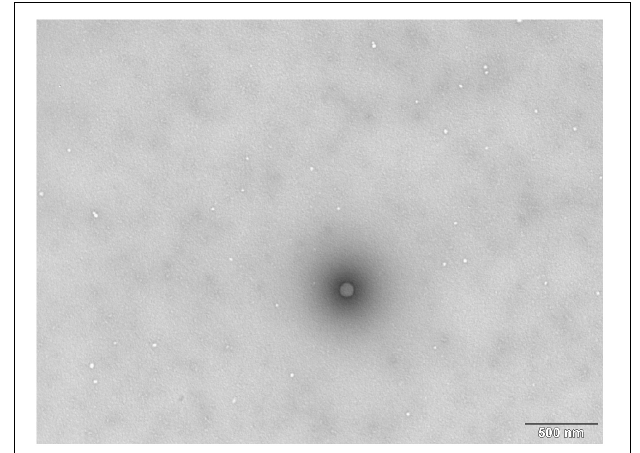
FIGURE 5 | Transmission electron microscopy photograph from TEM MS2 phage-like particles (MS2 PLP) quantification against latex standard. The large black “dot” is the latex standard and the white dots are MS2 PLP. The scale is 500